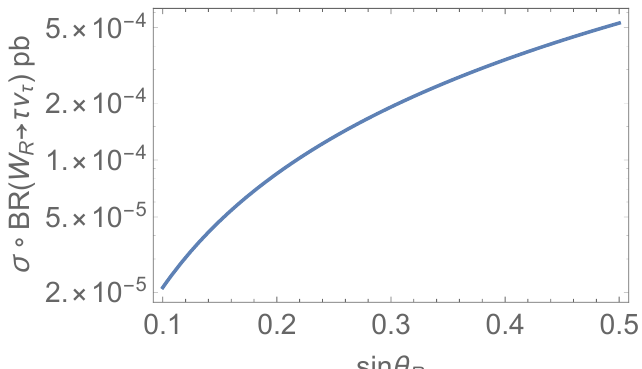
Figure 7 . Plot of (cid:27) ( pp ! W 1 ) (cid:2) B ( W 1 ! (cid:28) R (cid:23) (cid:28) ) as a function of sin (cid:18) R , for m 1 = 3 TeV and the R R R values of ( V y ) 23 ) required for the solution to the R ( (cid:3) ) u R D